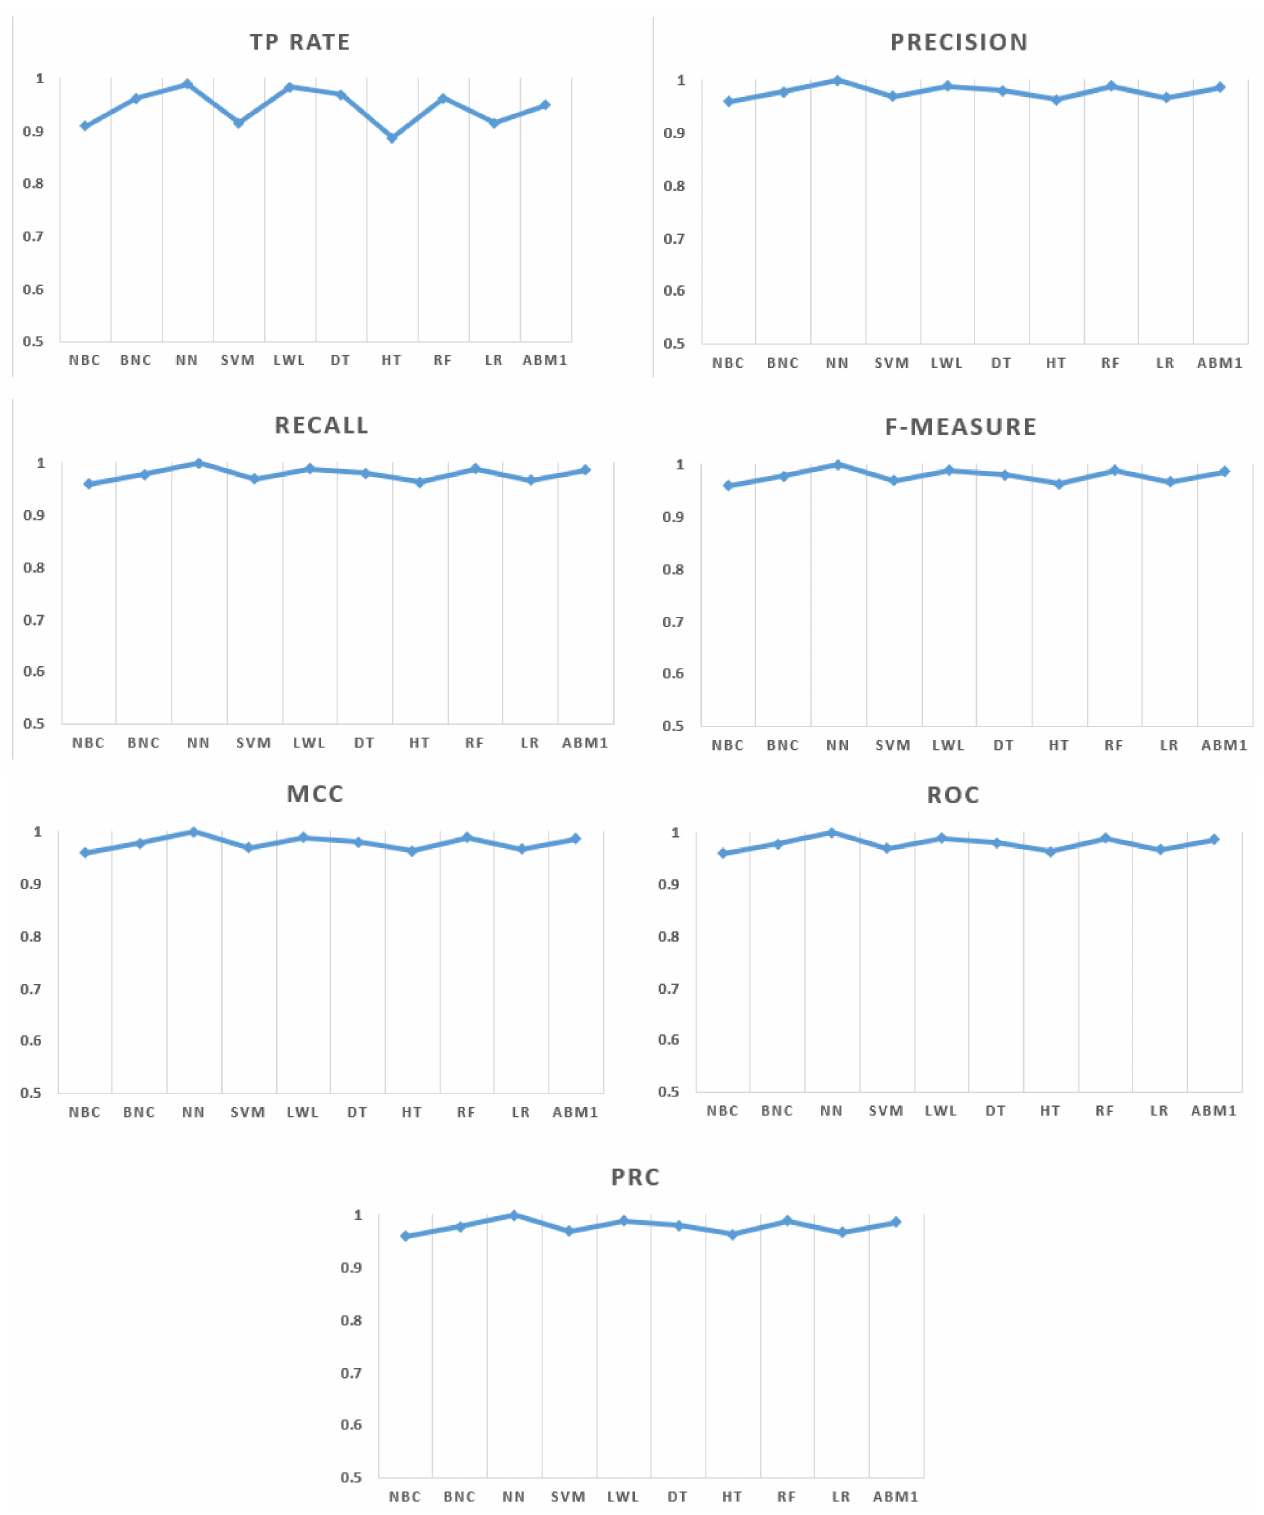
Figure 3. TP rate, FP rate, precision, recall, F-measure, MCC, ROC area, and PRC area for each